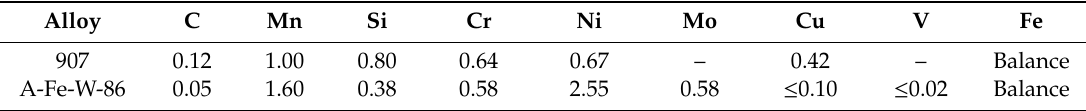
Table 1. Chemical compositions of substrate and wire